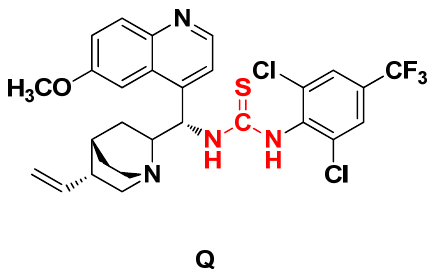
Figure 3. Structure of the cinchona alkaloid-derived thiourea